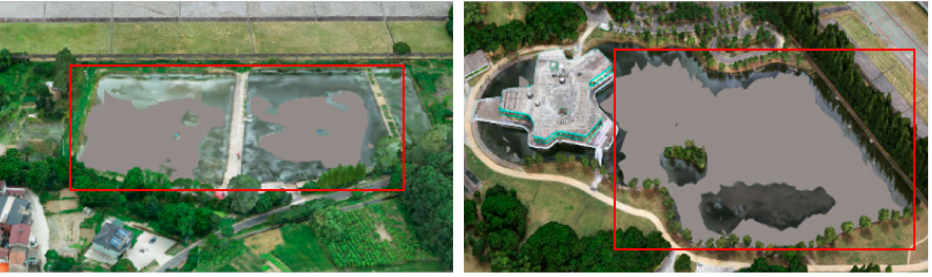
Figure 1. The effects of 3D reconstruction of water regions by UAV-based oblique photography technology, and the content in the red box corresponds to water regions in the real